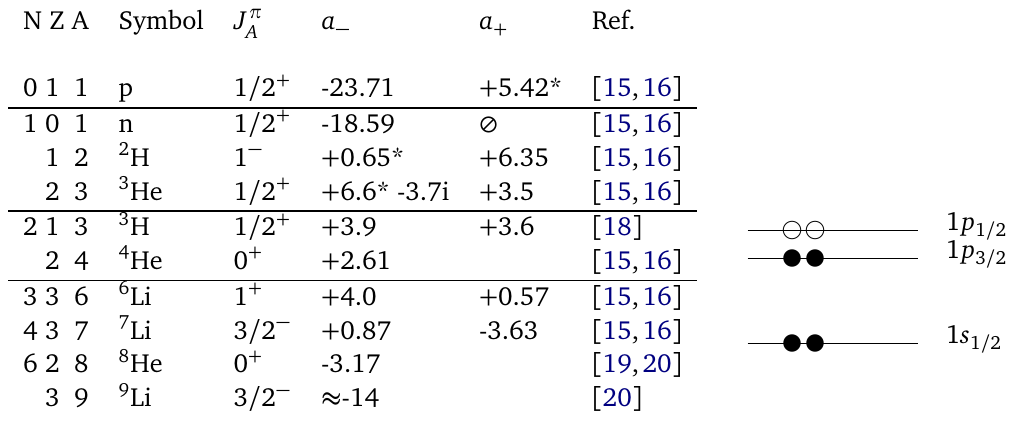
Table 1: In the left panel the spin-dependent experimental nA scattering length (fm) for light nuclei: we denote by a ± the S = J = 0 case or unassigned values of S (like 9 Li). Right panel represents the filled shell J A model neutron orbitals in 7